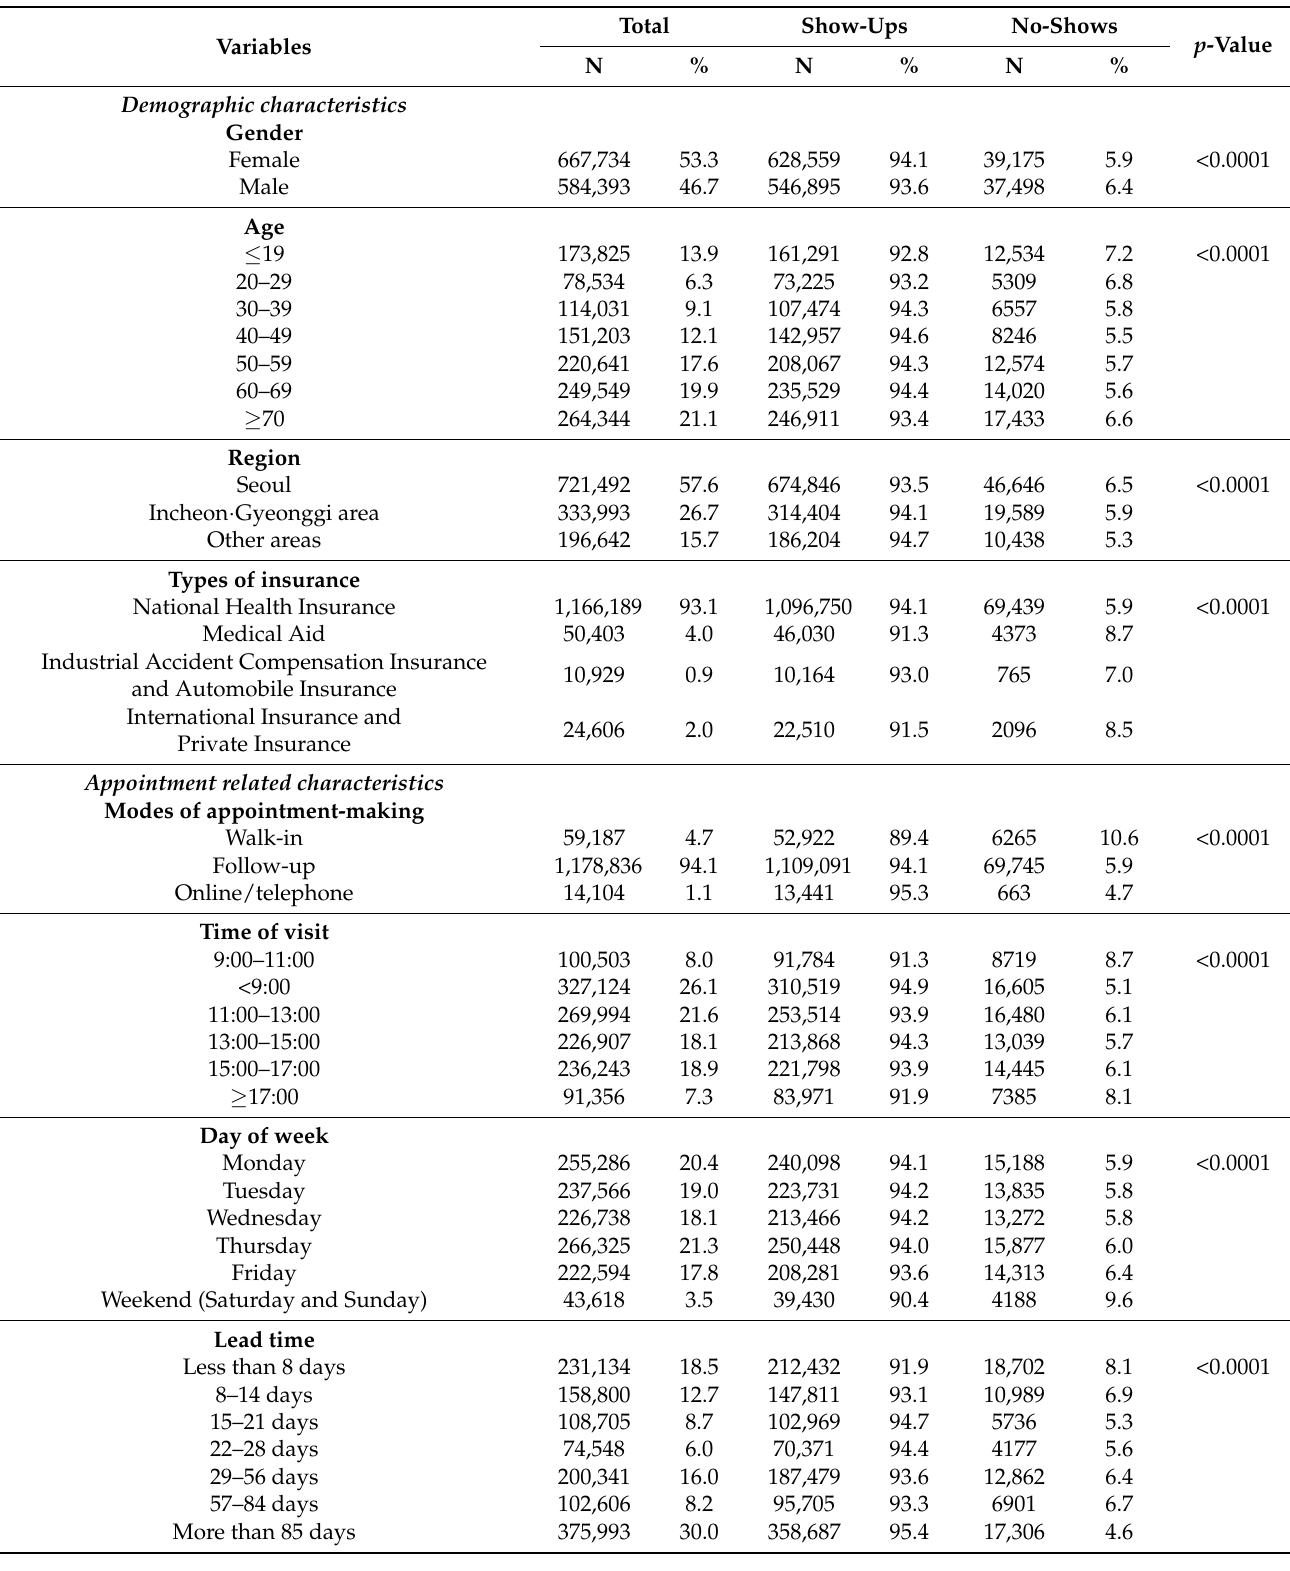
Table 1. Comparison between no-shows and